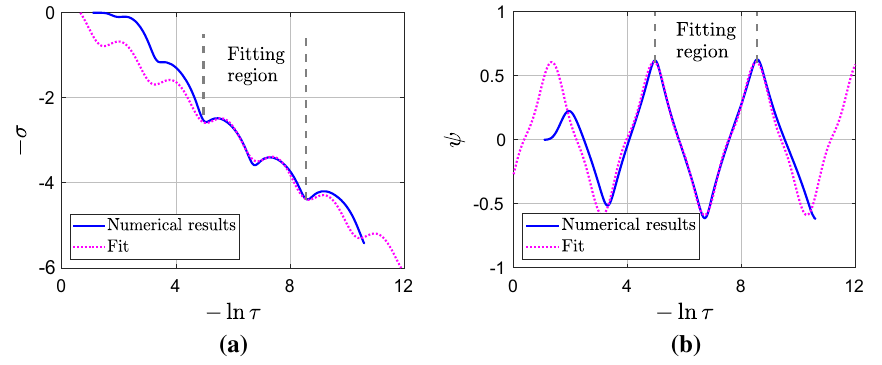
(cid:6) 4 a n cos ( n wζ) + b n sin ( n wζ) . The fit according to f (ζ) = a 0 + n = 1 period for ψ is T ψ ≈ 3 . 59, and ω is fixed to be ω = 2 π/ T ψ = 1 . 75. The fitting results are a 0 = 0 . 0106 ± 0 . 0004, a 1 = − 0 . 3451 ± 0 . 0006, b 1 = 0 . 3927 ± 0 . 0007, a 2 = 0 . 0100 ± 0 . 0006, b 2 = − 0 . 0001 ± 0 . 0006, a 3 = 0 . 0546 ± 0 . 0006, b 3 = 0 . 0508 ± 0 . 0006, a 4 = 0 . 0007 ± 0 . 0006, b 4 = 0 . 00035 ± 0 . 00059. Slice: x = 4 . 75 × 10 −